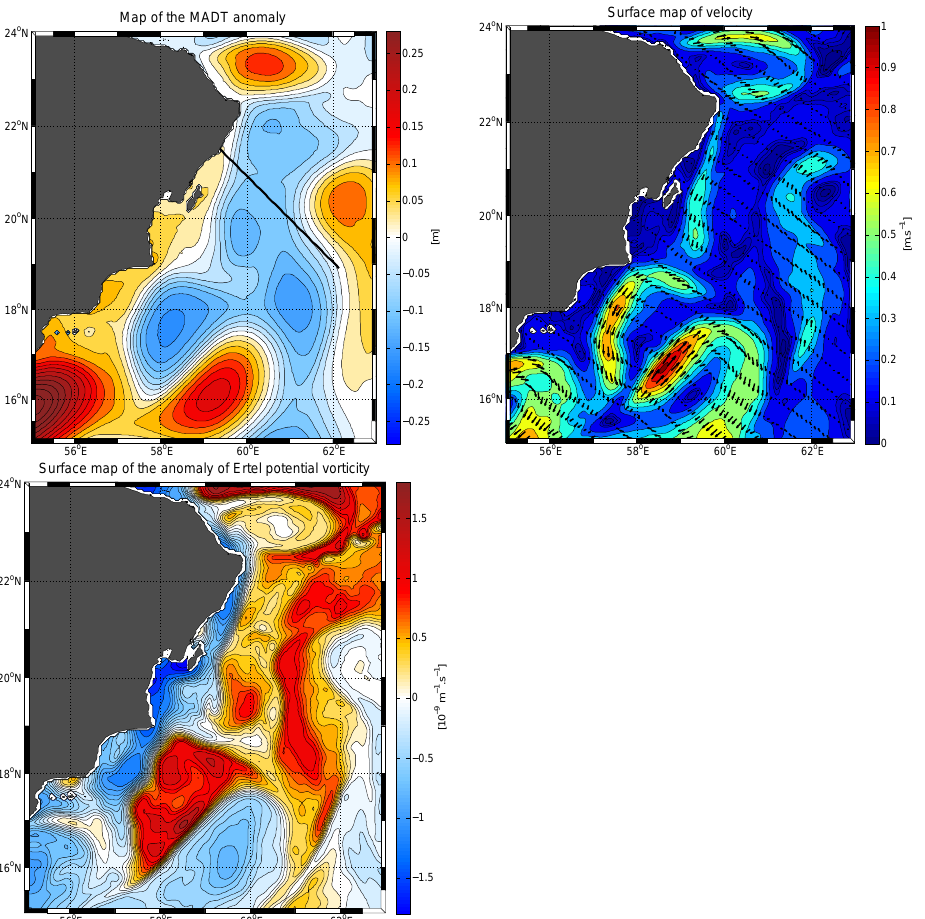
Figure 5. Maps from HYCOM during the winter monsoon, showing the presence of the coastal current: (top left) MADT anomaly; (top right) surface velocity; (bottom) anomaly of Ertel potential vorticity. The anomalies of altimetry and Ertel potential vorticity have an opposite sign along the coast, in the current, and offshore. The position of the cross section is indicated on the upper left